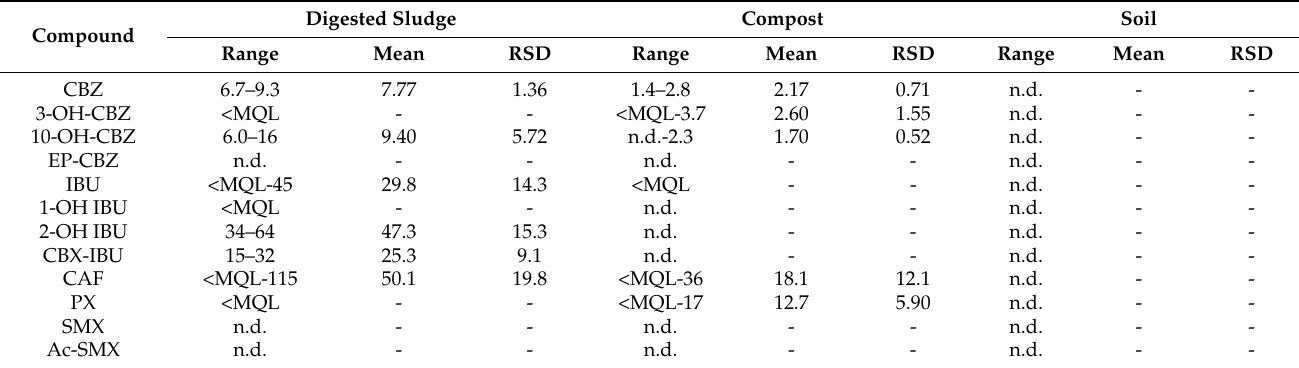
Table 1. Concentration levels (range (ng g − 1 dm), mean (ng g − 1 dm) and RSD (%)) of the selected PhCs and their metabolites in solid samples ( n = 5).